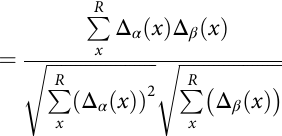
ffiffiffiffiffiffiffiffiffiffiffiffiffiffiffiffiffiffiffiffiffiffiffi P R